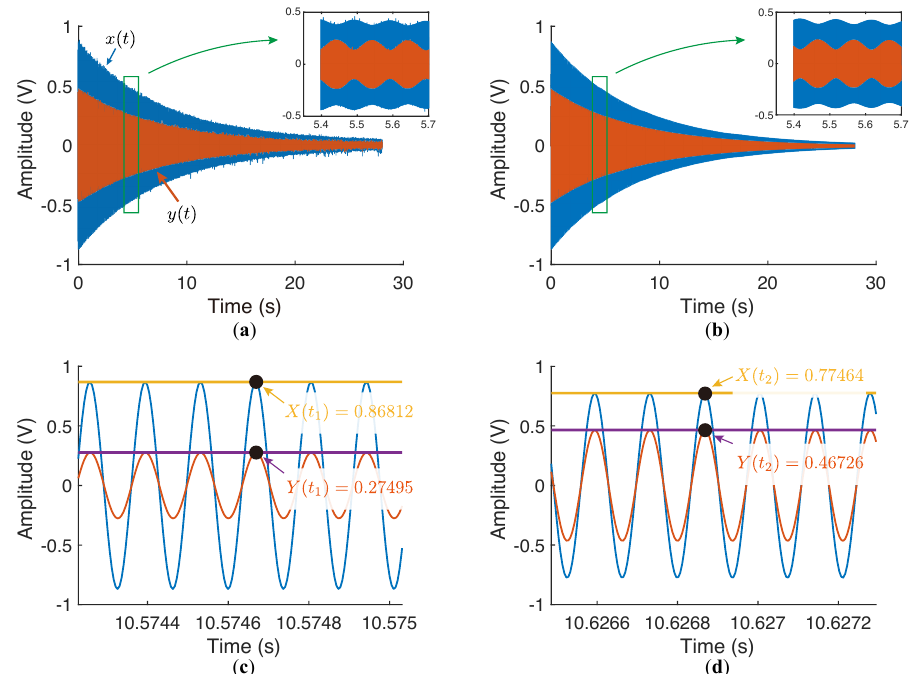
Figure 16. The measured ring-down signals and the peaks and the valleys of the beats. ( a ) The original signals sampled from XY directions. ( b ) The signals passed through the bandpass filter. ( c ) Zooming at the position of the peak of X ( t ) . ( d ) Zooming at the position of the peak of Y ( t ) .